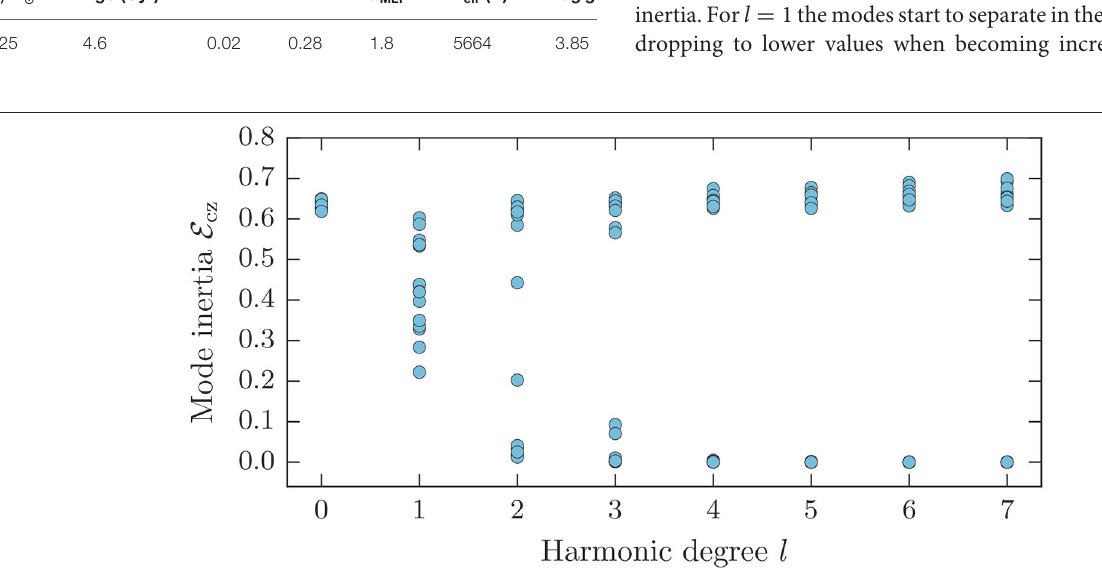
0, ... ,7 and all radial orders n occurring in the frequency range =